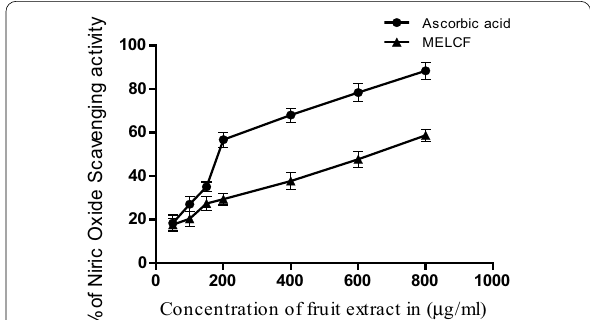
Fig. 2 In vitro alpha glucosidase inhibitory activity of acarbose and MELCF. The values are represented as an average of triplicate trials, the error bars are SEM values